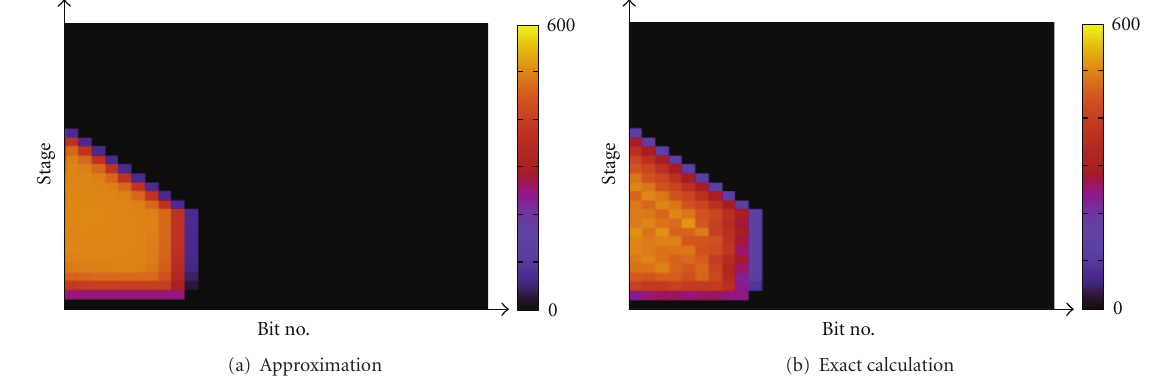
Figure 15: Toggle distribution estimation.